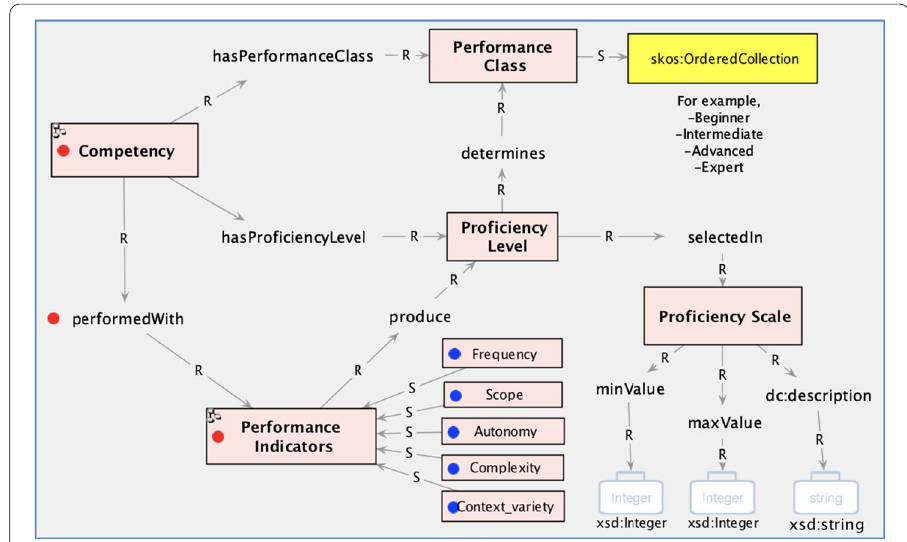
Fig. 4 The proficiency level